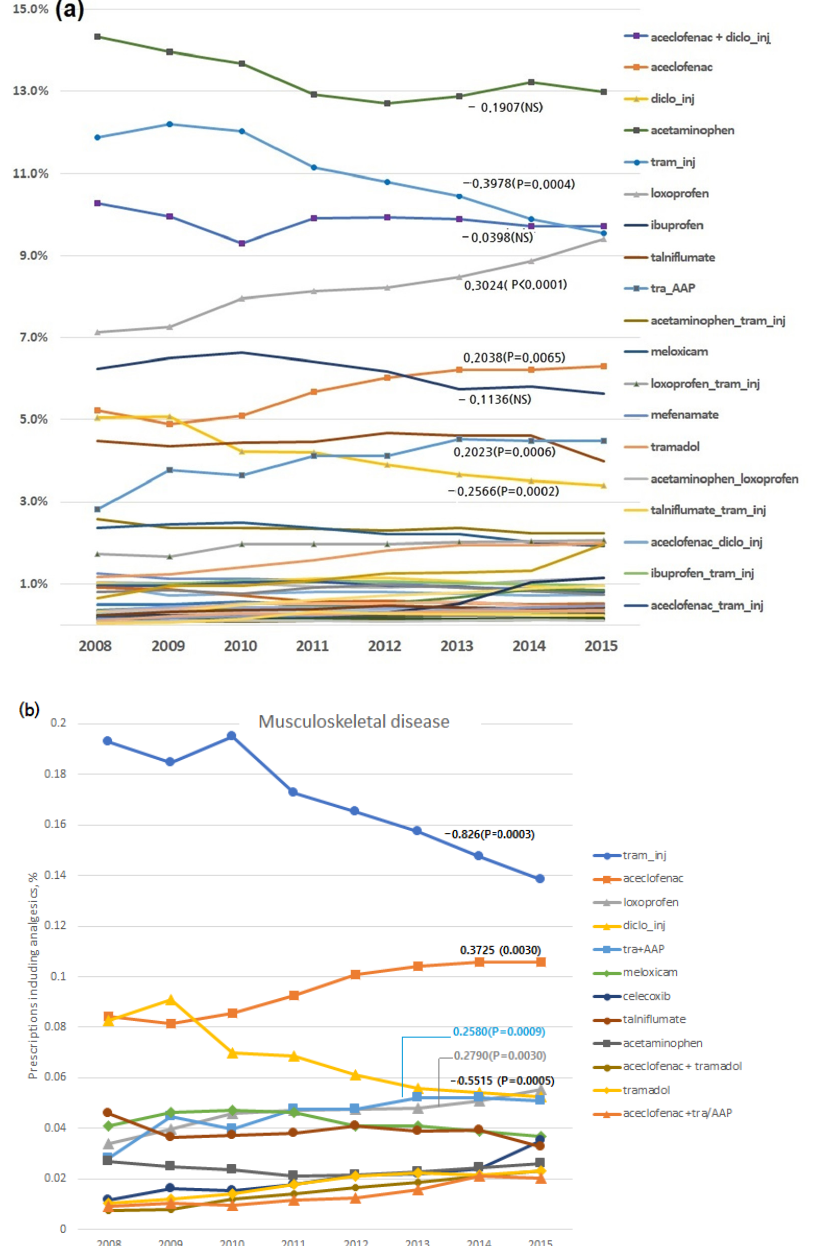
Figure 3. Time trends in the proportion of prescribed analgesics among patients with a history of MI during study years and time trend analysis (trends’ significance was expressed as beta value and p -value): ( a ) Overall trends in individual analgesics and ( b ) trends in musculoskeletal diseases (left: the proportions of the prescribed analgesics, right: time trends of individual analgesics). AAP: Acetaminophen, NS: Not Significant, tram: tramadol.